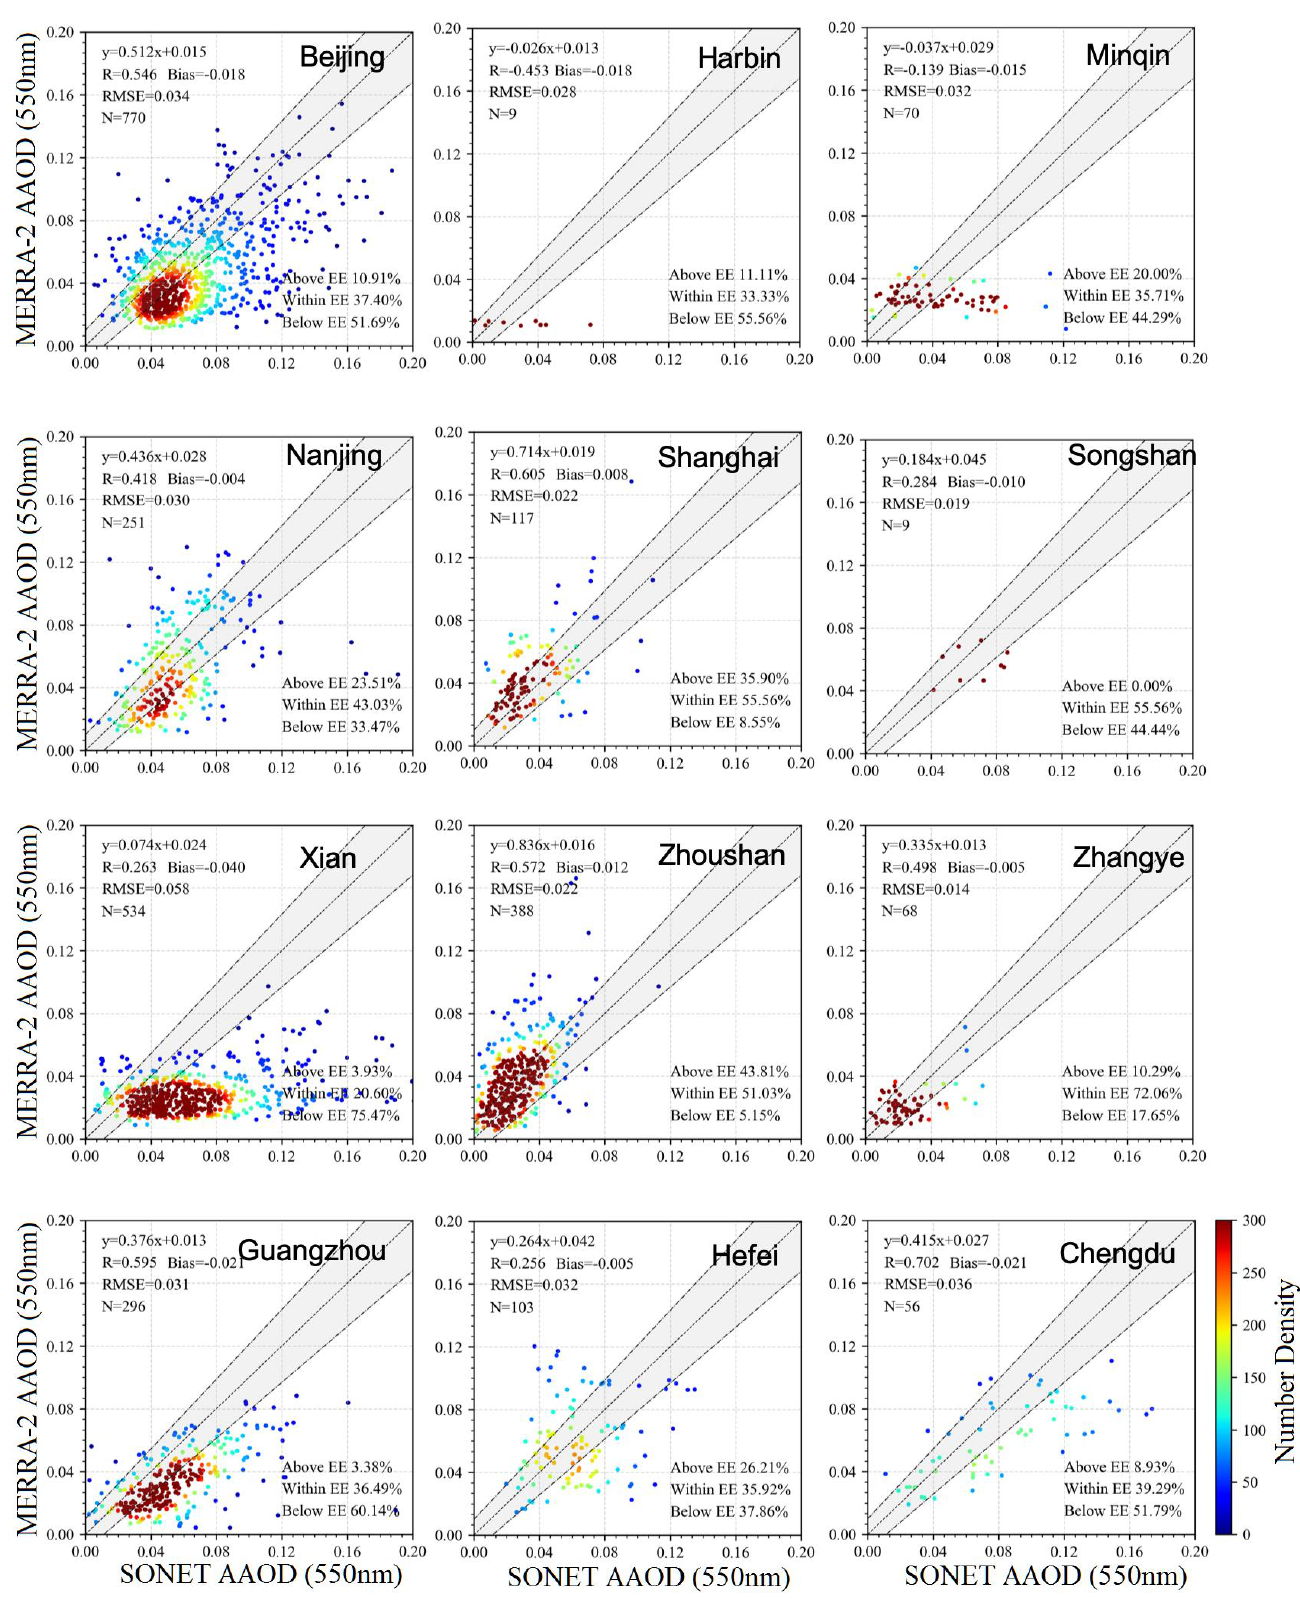
Figure 6. Same as Figure 2, but for AAOD.